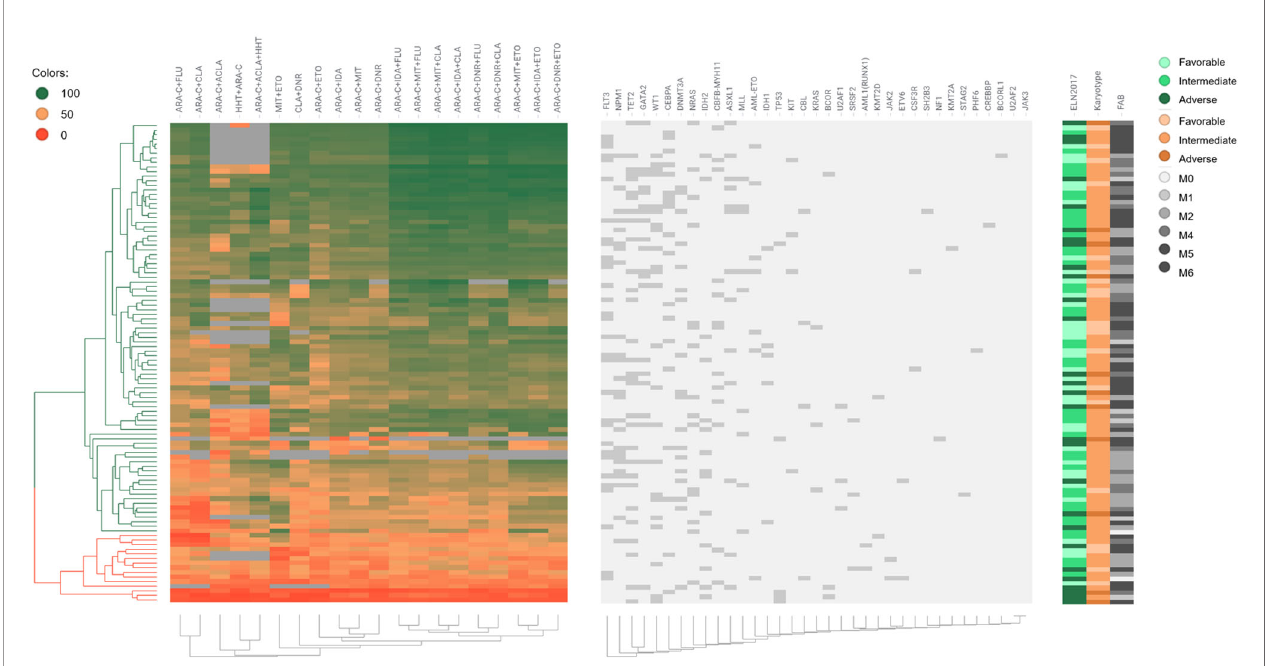
FIGURE 1 | Drug sensitivity heat map of 104 AML patients. Each row represents a patient; each column represents a treatment or a stated gene; different colors represent different drug sensitivities per patient; the left side of the graph annotates the classi fi cations of ELN 2017, karyotype, and FAB; the upper histogram shows the name of treatments and gene